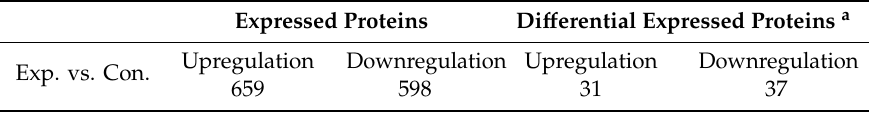
Table 2. Summary of expressed proteins in C. vulgaris